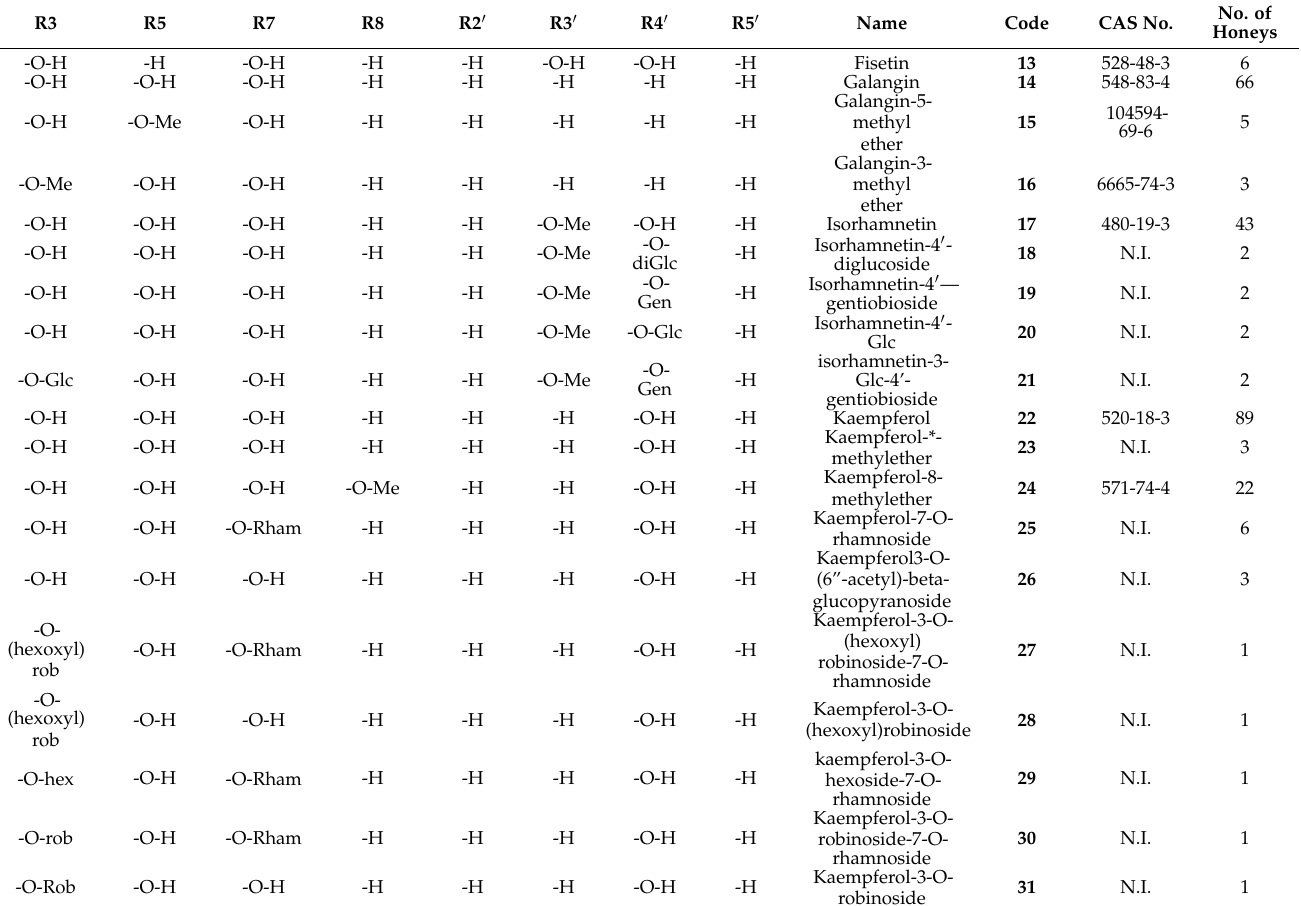
Table 3. Flavonols reported in monofloral honeys (see Figure 8 for general